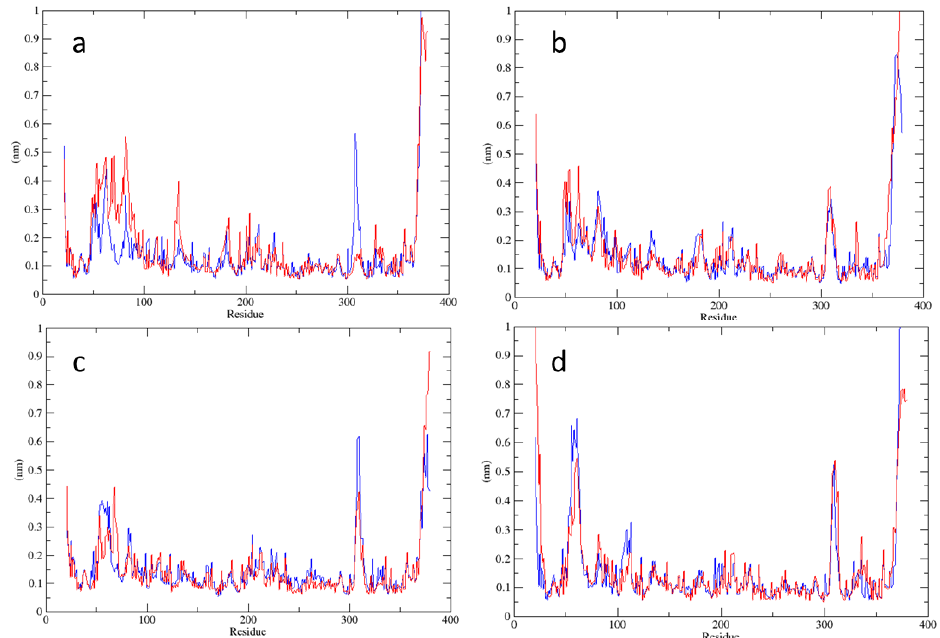
Figure 4. RMSF analysis for simulations at 334 K of: ( a ): wtGALT; ( b ): p.Gln188Arg; ( c ) wtGALT + G1P + H2U; ( d ) p.Gln188Arg + G1P + H2U. Blue lines represent RMSF fluctuation of chain A, red lines of chain B.